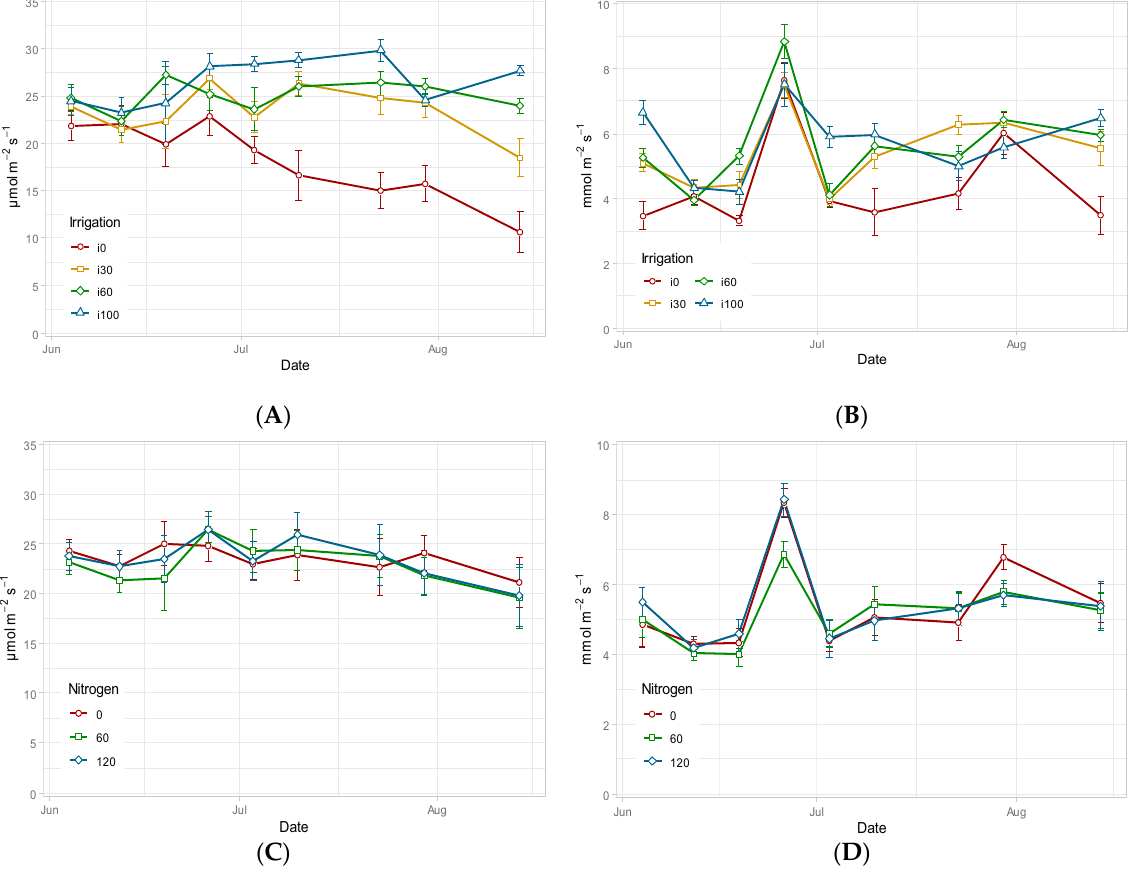
Figure 5. ( A ) Net photosynthesis (µmol CO 2 m − 2 s − 1 ) according to the irrigation level and ( C ) nitrogen fertilization levels. ( B ) Transpiration rate (mmol H 2 O m − 2 s − 1 ) according to the irrigation level and ( D ) nitrogen fertilization levels.